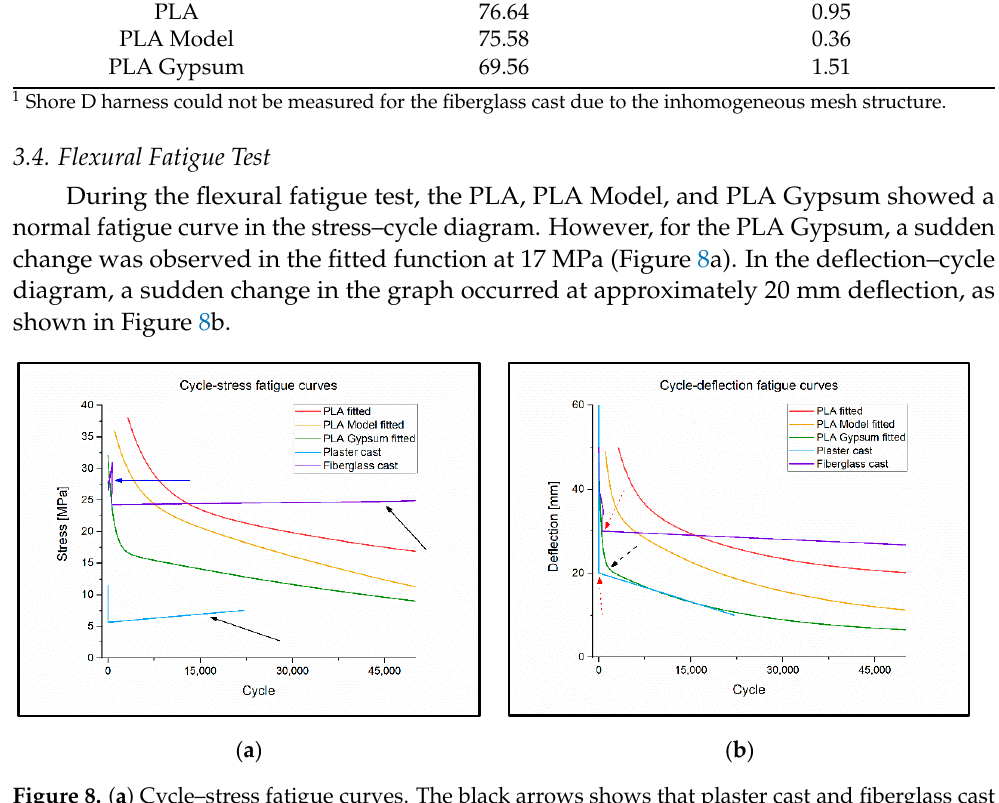
Figure 8. ( a ) Cycle–stress fatigue curves. The black arrows shows that plaster cast and fiberglass cast do not follow the decreasing trend. The blue arrow shows that the fiberglass swings above 26 MPa stress. ( b ) Cycle–deflection fatigue curves. The red dotted arrows on the diagram show that the plaster cast and the fiberglass cast did not follow the classic s–n curve and also have a break point in the function. The black dashed arrow indicates that the function fitted to the measured values of PLA Gypsum with higher gypsum content suddenly changes.